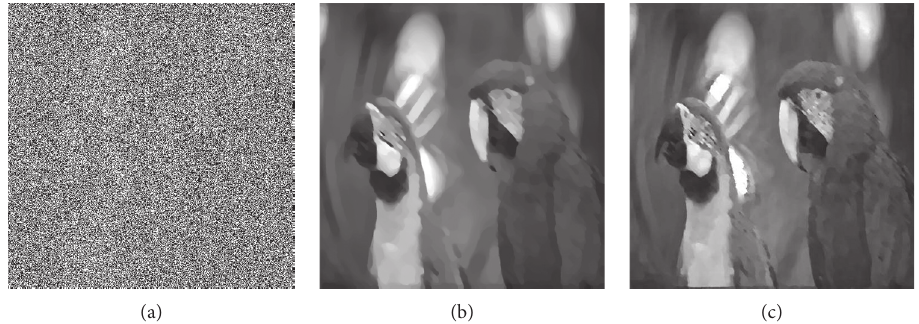
Figure 20: The recovery results (macaws 512 × 512) by Motion blur with 90% SP noise. (a) Motion blur (lev � 0.9). (b) L0TV, PSNR � 27.1022. (c) LogTVSCAD, PSNR �